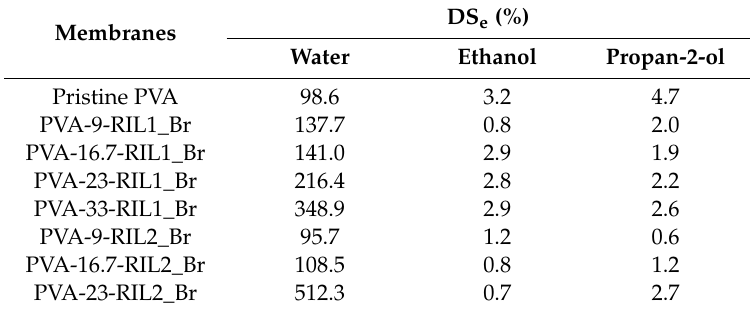
Table 4. The DS e Values of PVA-RIL1 and PVA-RIL2 Membranes in Water, Ethanol and Propan-2-ol.